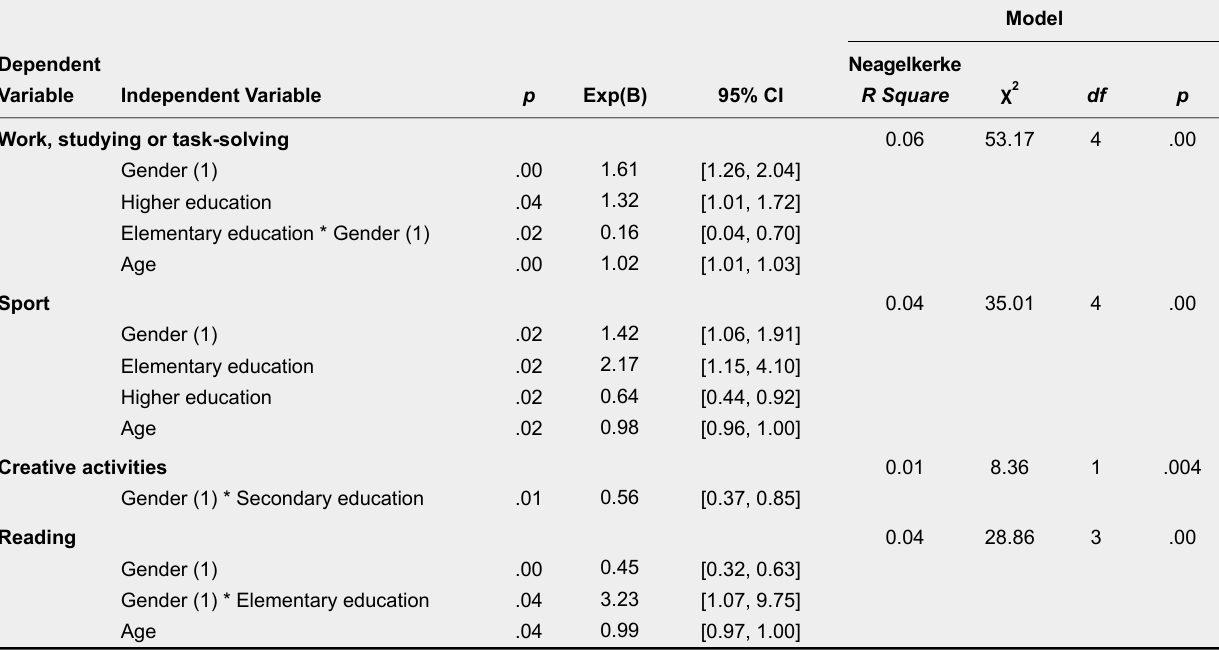
Binary Logistic Regression About the Predictive Variables Related to the Probability of Experiencing Flow in Different Individual